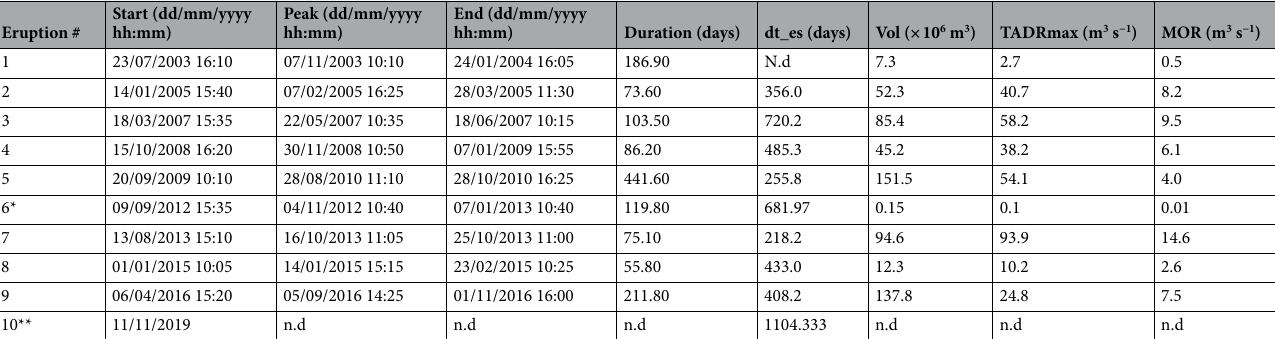
Table 1. Eruptions and parameters of Klyuchevskoy volcano retrieved from MODIS data. Volumes, TADR and MOR are calculated as bulk values (see “Methods”). *Eruption #6 was detected by MODIS but with TADR < 0.25 m 3 s −1 . Eruption start and end, are selected manually based on first and last thermal anomalies. **Start of Eruption #10 from 39